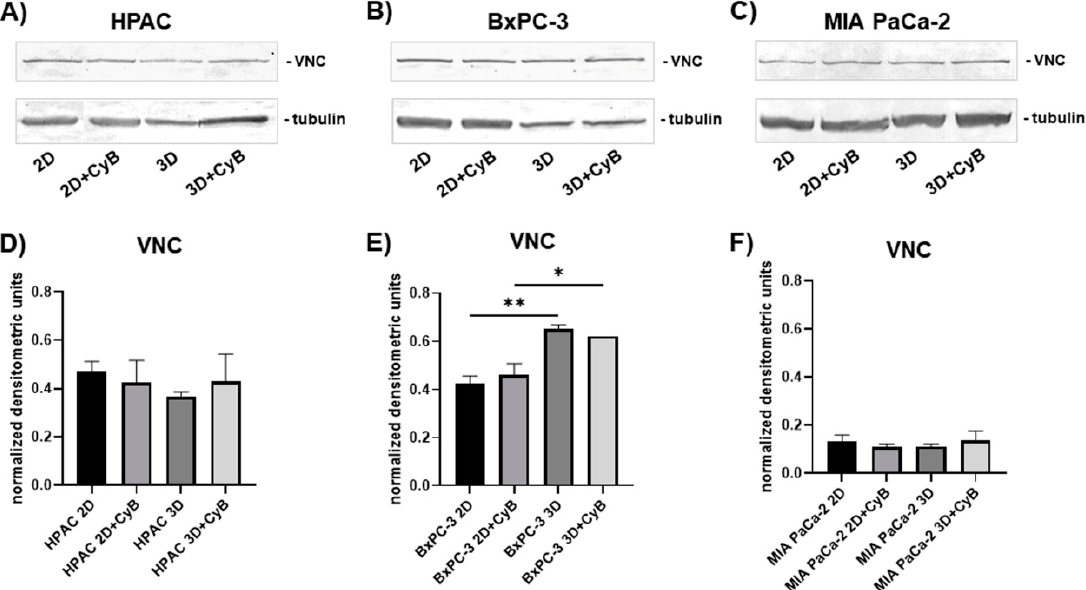
Figure 5. Representative Western blot showing VNC expression in whole cell lysates of HPAC ( A ), BxPC-3 ( B ) and MIA PaCa-2 cells ( C ). Bar graphs showing E-cadherin protein levels after densitomet- ric scanning of immunoreactive bands in HPAC ( D ), BxPC-3 ( E ) and MIA PaCa-2 cells ( F ). Data are expressed as mean ± SD. * p < 0.05, ** p <